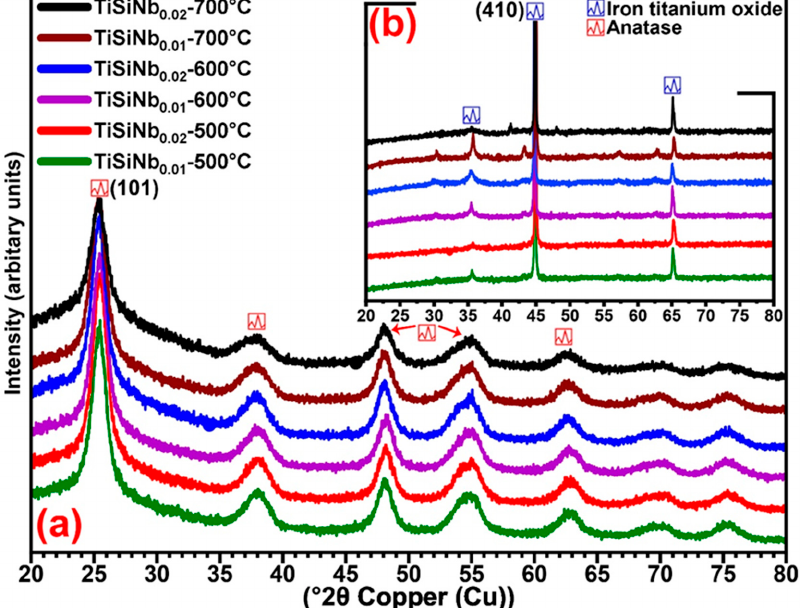
Figure 6. XRD patterns of TiSiNb powders ( a ) and TFSOC ( b ) at different annealing temperatures in N 2 atmosphere. N 2